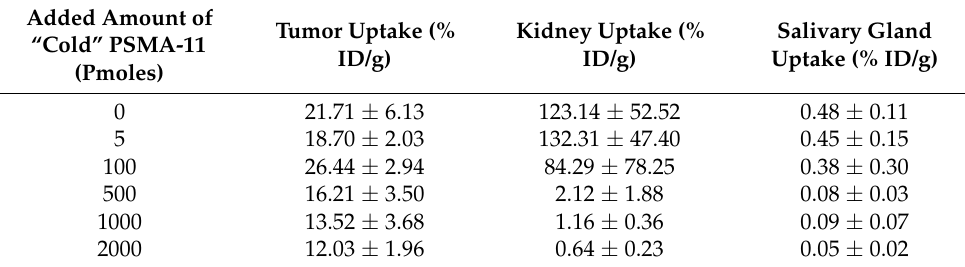
Table 2. Biodistribution data of [ 177 Lu]Lu-PSMA-617 (5 pmoles) with co-injected non-radioactive PSMA-11 for tumor and selected non-target organs one hour after injection in athymic mice bearing PC-3 PIP tumors